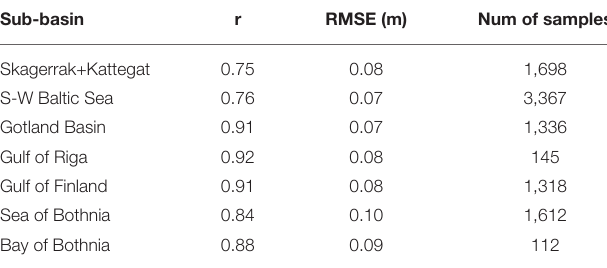
TABLE 2 | Pearson Correlation Coefficient and RMSE between TGs and gridded altimetry averaged in space over the sub-basins considered in this study and in time every 3